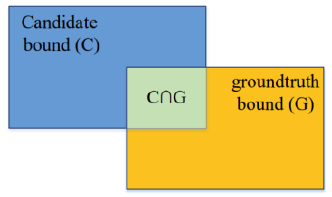
Figure 6. IoU calculation diagram.